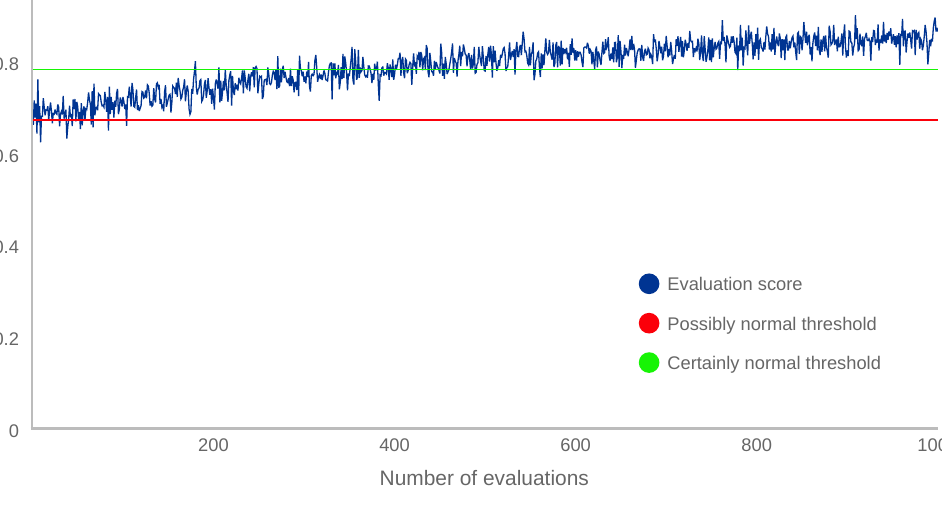
Figure 8. Sensor evaluation scores of the new sensor vectors as the number of similar new vectors